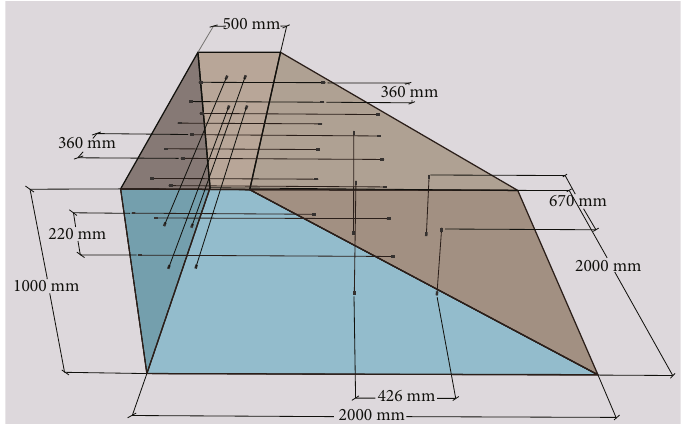
Figure 5: Three-dimensional plan of the distribution spacing of optical fi bers.